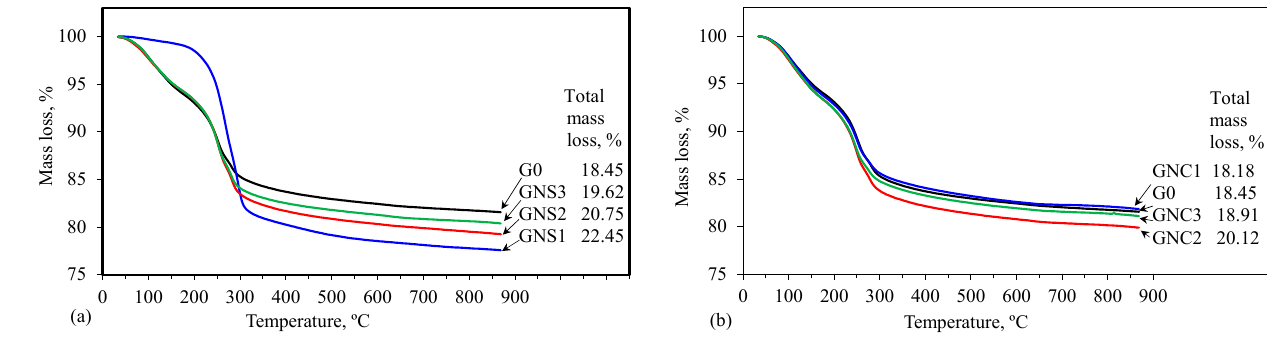
Figure 10. TG curves for cement pastes containing NS ( a ) and NC ( b ).